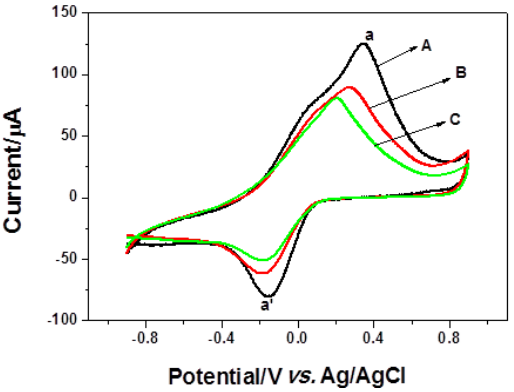
Figure 8. Cyclic voltammograms of ( A ) GCE/PDMA-MWCNT; ( B ) GCE/PDMA-MWCNT after immobilization of the FB 1 antibody and ( C ) GCE/PDMA-MWCNT after immobilization and running in FB 1 antigen in PBS at a scan rate of 50 mV·s − 1 .